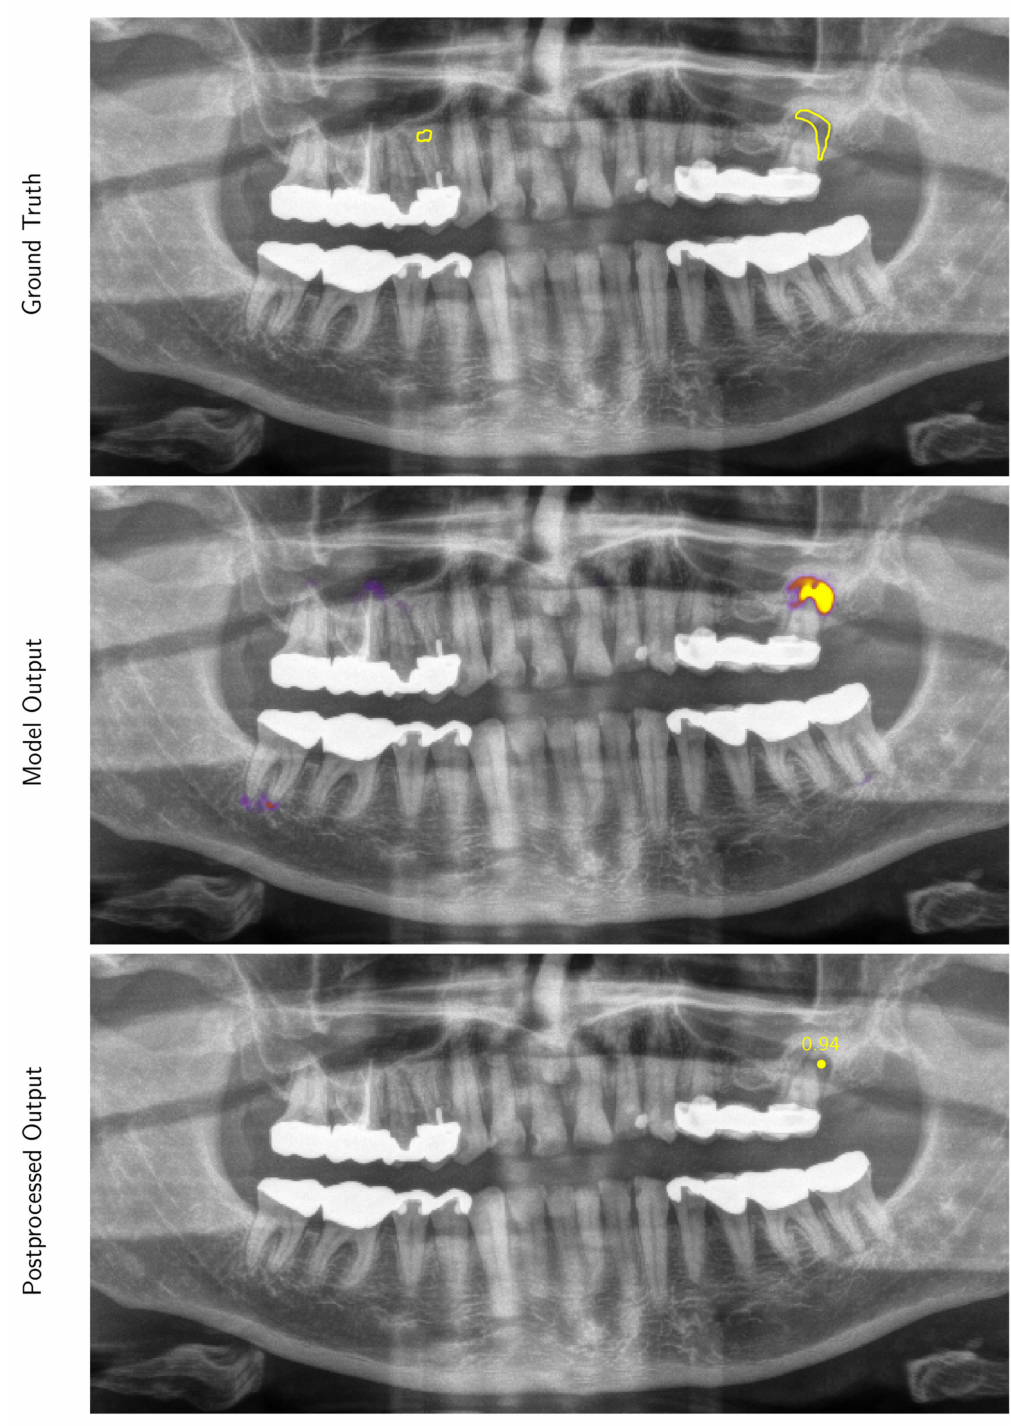
Figure A1. Example 1 of a panoramic radiographic image (preprocessed for model input) selected from the test data set with overlays of the ground truth contours (Ground Truth), the intensity map output produced by our model (Model Output) and locations produced by our post-processing procedure (Postprocessed Output). Only predictions with a confidence score greater than 0.25 are displayed as an example (this threshold was selected to maximize the F 1 score on the validation data